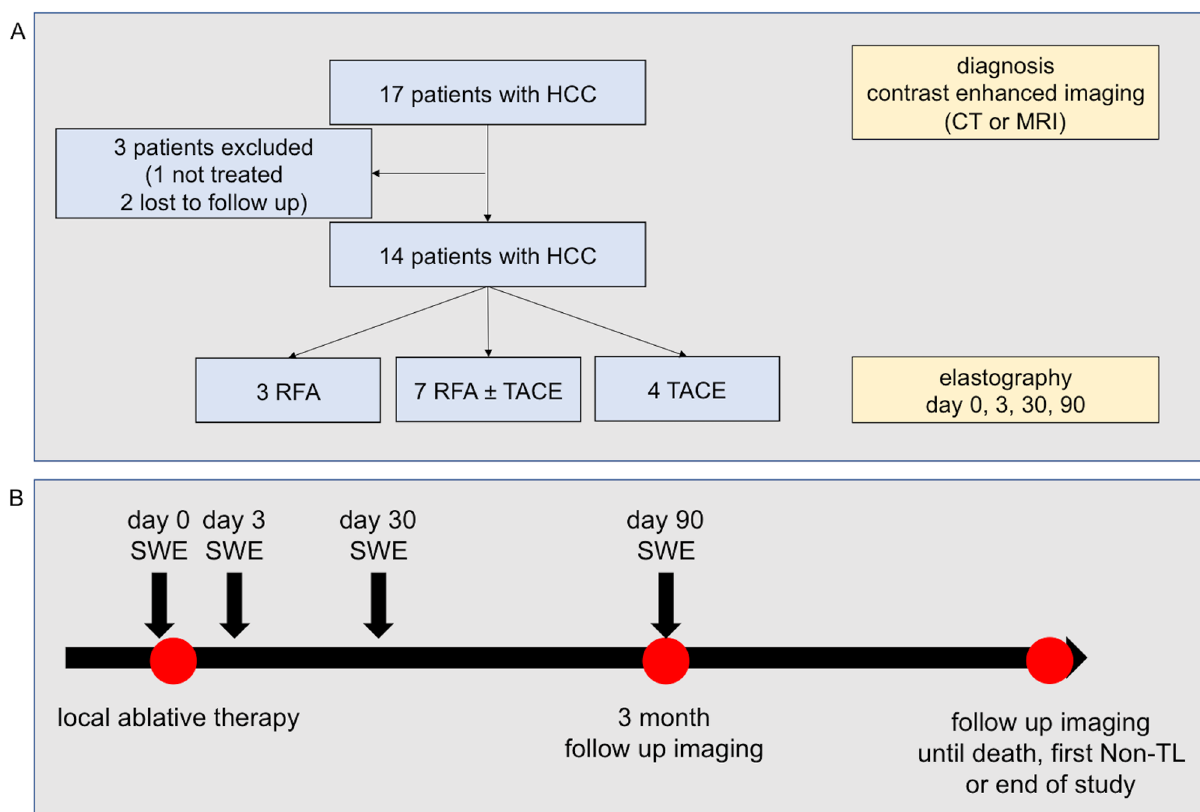
Fig 1. Study flow (A) and study design